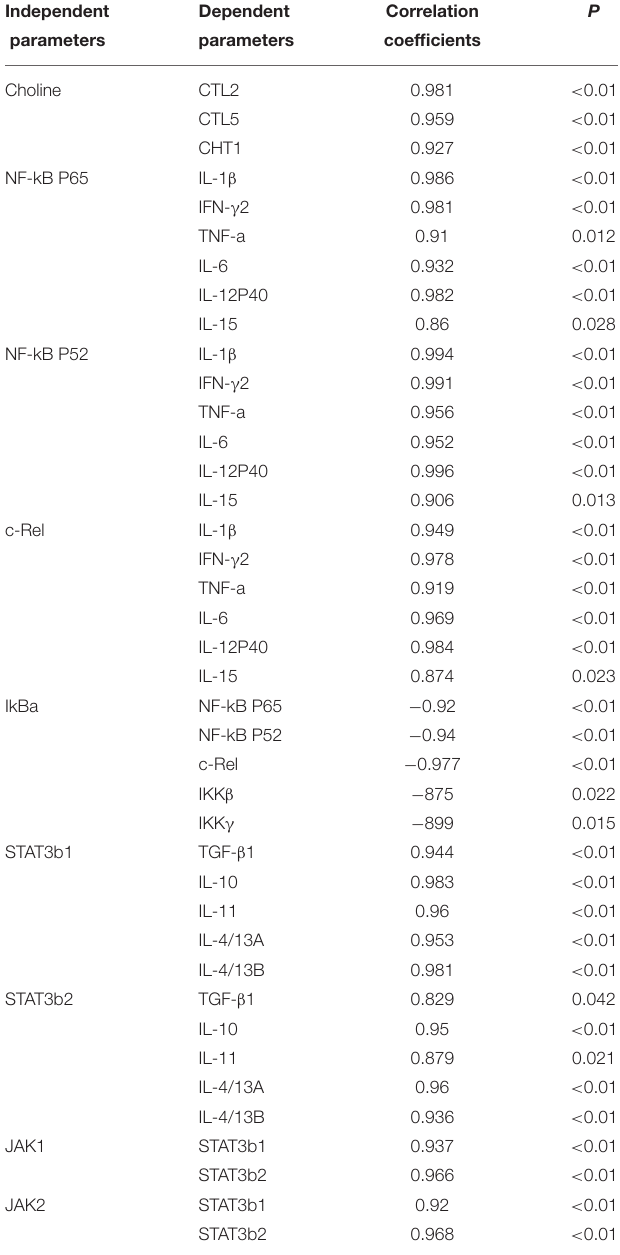
TABLE 5 | Correlation analysis of parameters in the skin of juvenile grass carp ( Ctenopharyngodon idella ).